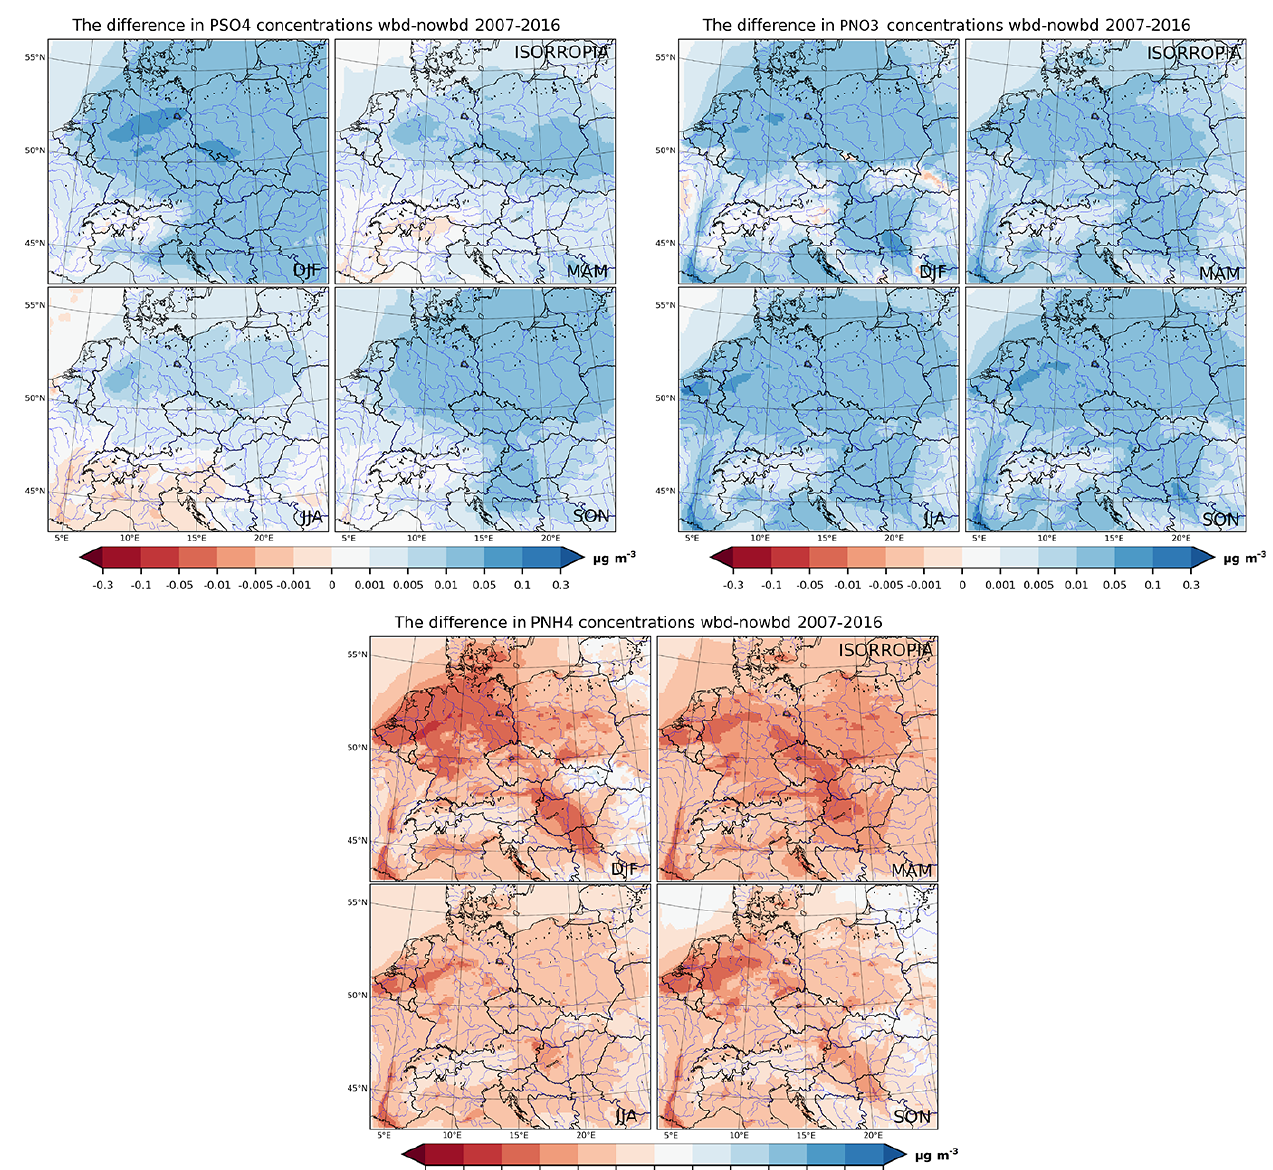
Figure 21. The WBD emission impact on secondary inorganic aerosol concentrations (PSO 4 , PNO 3 and PNH 4 ) with ISORROPIA, season- ally averaged, in micrograms per cubic metre for